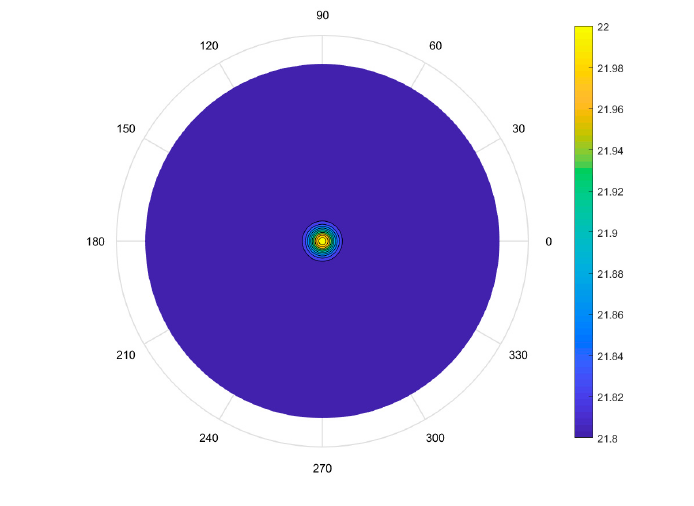
t = 0.275 s, Δ T = 0.2 ℃ (2D plot of simulations) ( b ): The ∆ T images of the CFRP specimen after the impact with a steel ball (experiments vs. simulations).